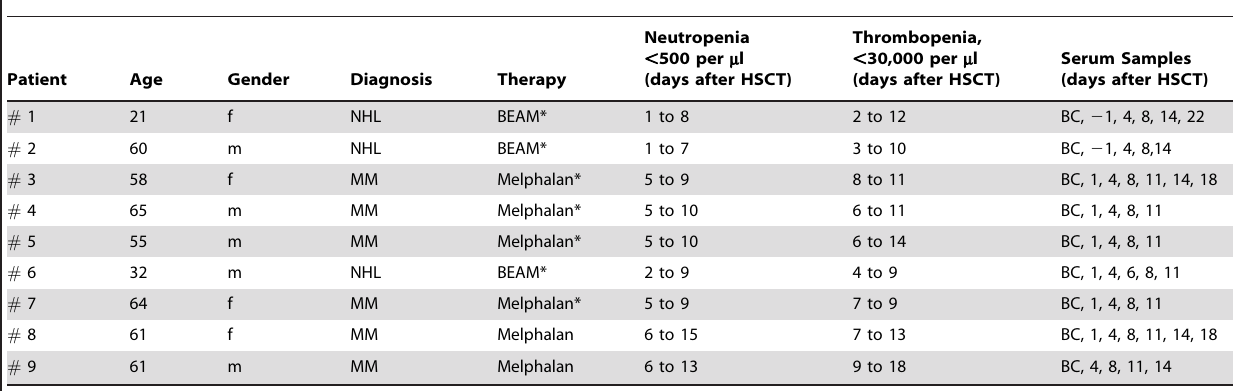
Table 1. Serum samples for culture expansion of